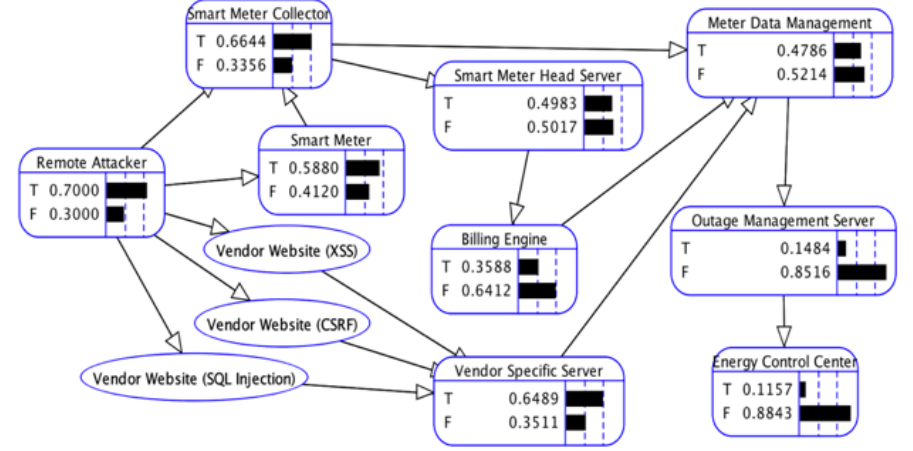
Figure 8. BAGS simulation results: function nodes using the Bayes.jar tool. (XSS refers to Cross Site Scripting; CSRF refers to Cross Site Request Forgery).